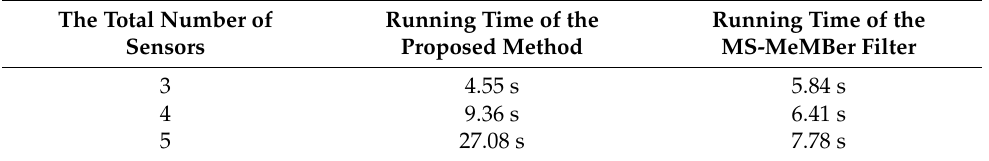
Table 2. Average running